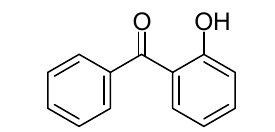
Figure 5. 2-Hydroxybenzophenone.